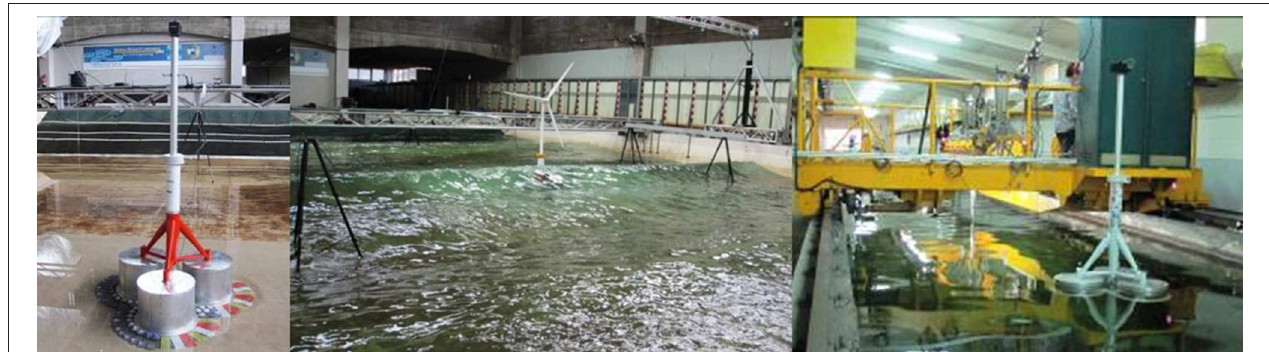
FIGURE 10 | GRAVI3 ® Physical campaign conducted at HRL-UPM and CEHINAV.